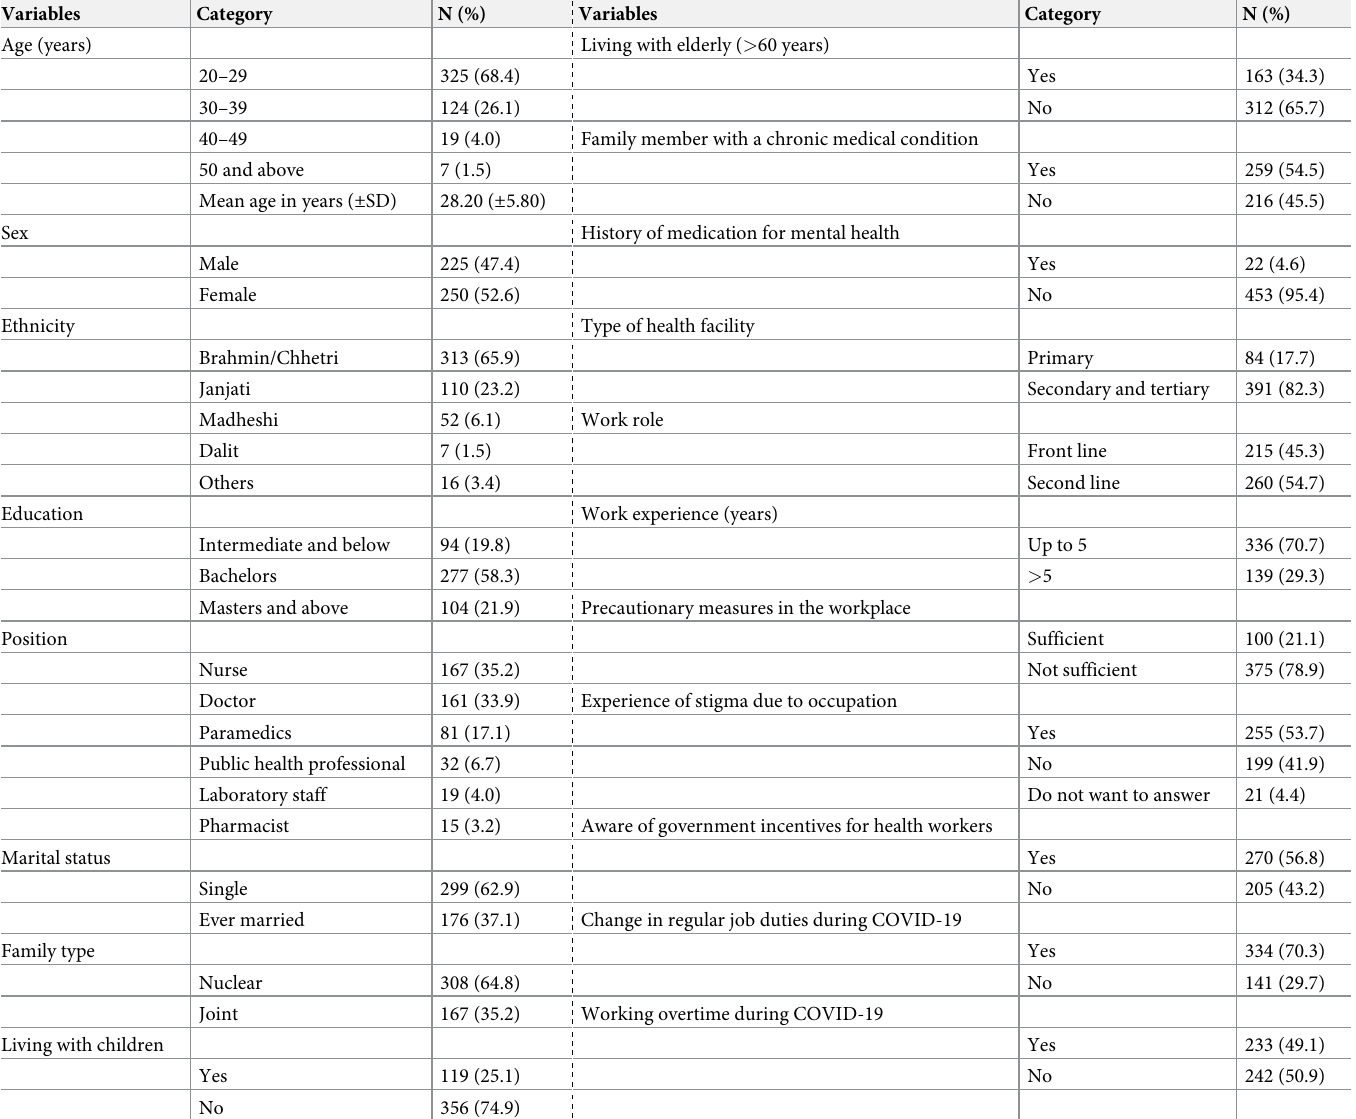
Table 1. Sociodemographic and job-related characteristics of health